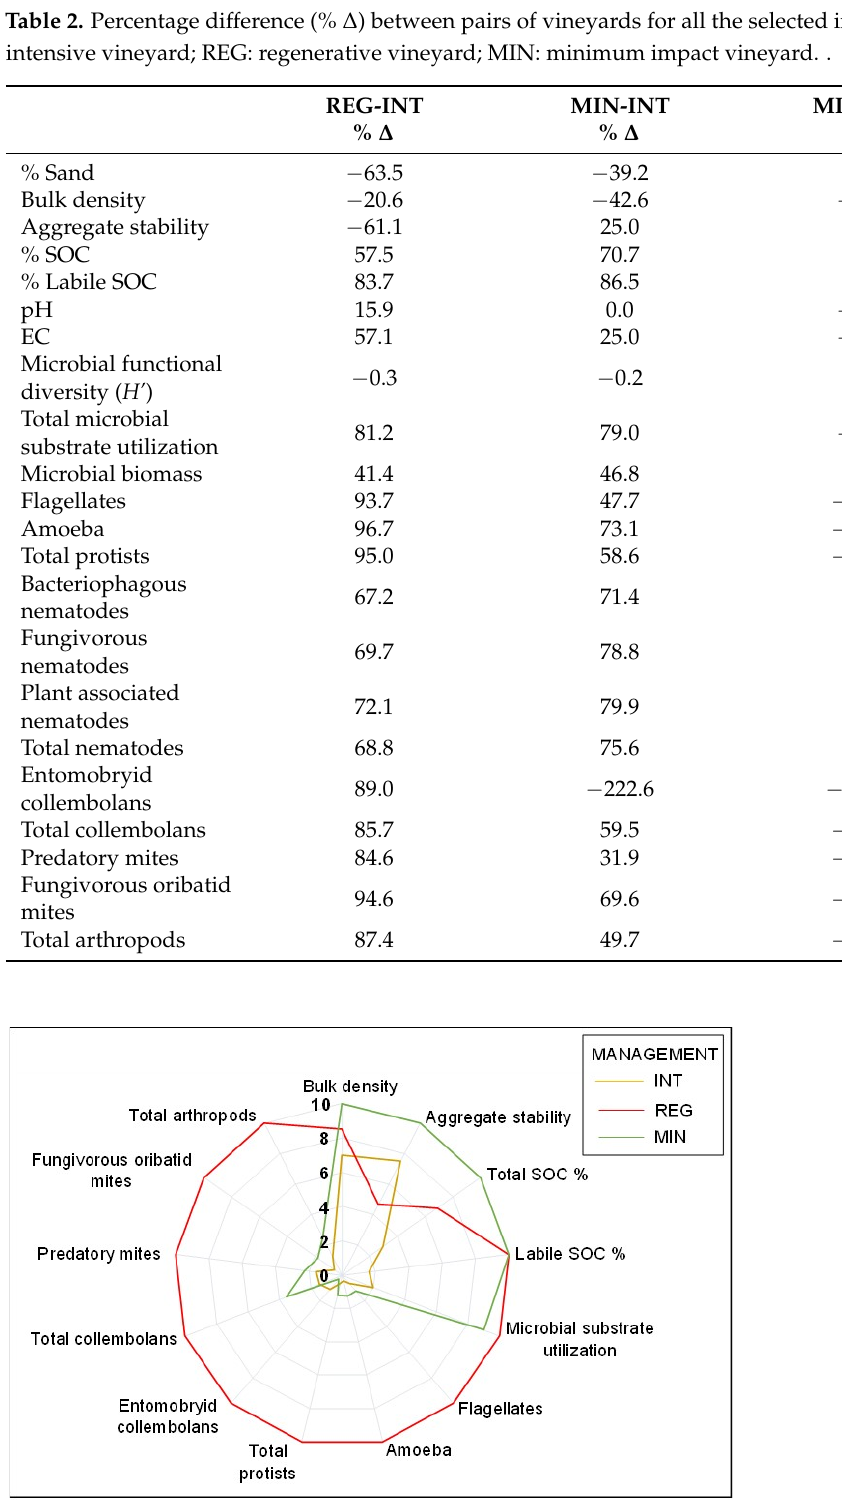
Figure 6. Spider graph showing the performance of the three vineyards for the most discriminating indicators. The value of each indicator is standardized relative to its maximal value in the three vineyards. For bulk density that is inversely related to soil quality, standardization was done based on the lowest value in the three vineyards. (INT) intensive vineyard; (REG) regenerative vineyard; (MIN) minimum impact vineyard.